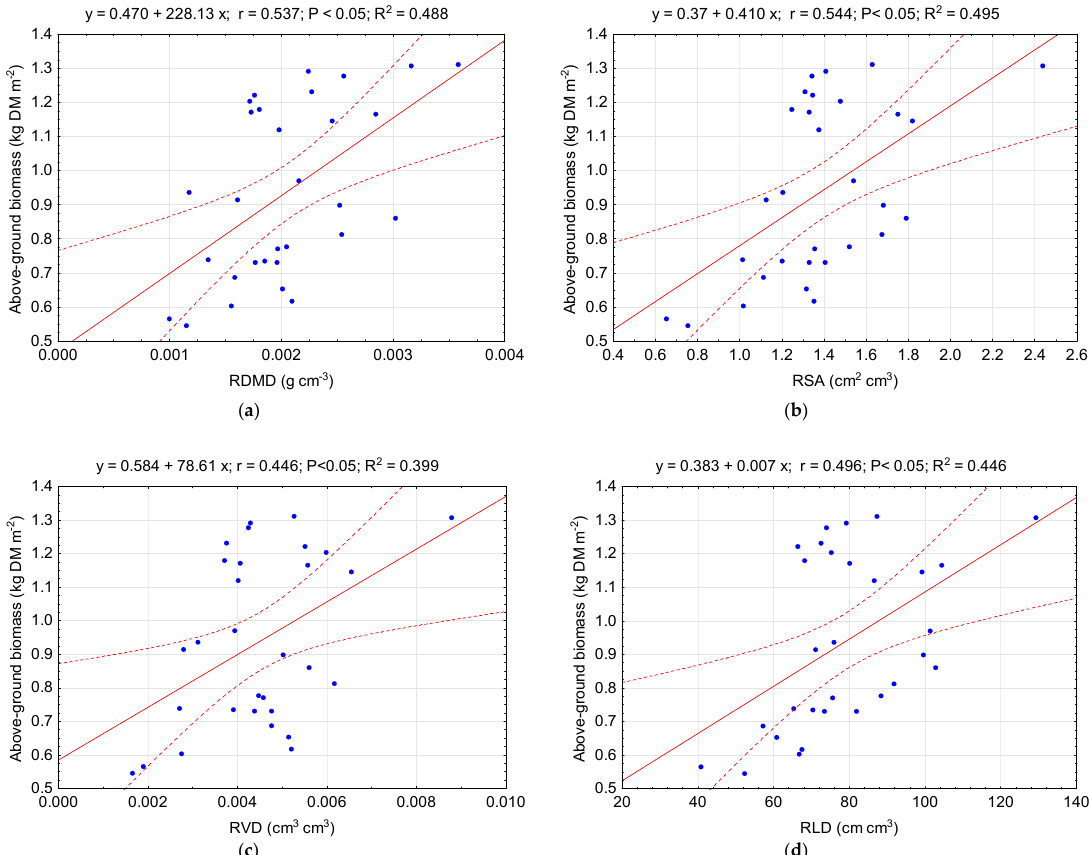
Figure 5. Relationship between root morphometric parameters, root dry matter density (RDMD) (a), root surface area density (RSA) (b), root volume density (RVD) (c), root length density (RLD) (d) and annual above-ground biomass productivity of perennial ryegrass. Solid line: fitted linear regression, dotted lines: 0.95 confidence interval.